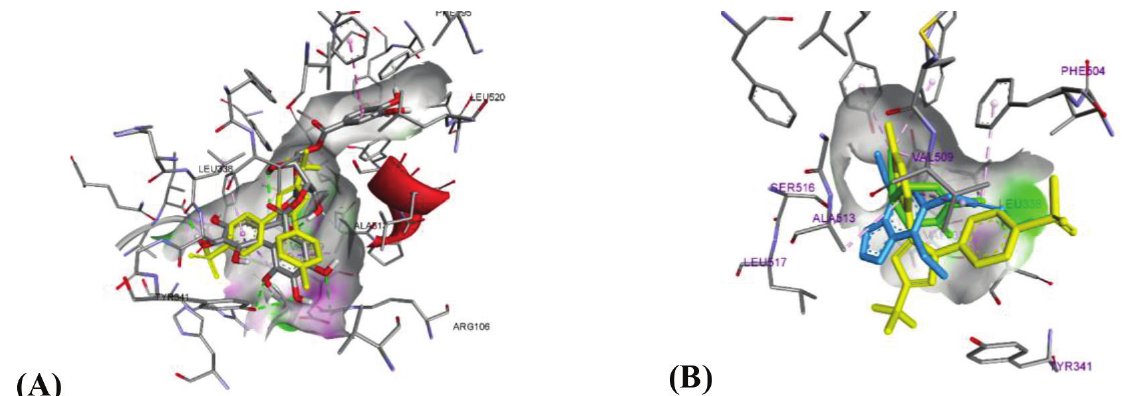
Figure 8. 3D visualization of ( A ) conformation of the native celecoxib ligand (yellow molecule) with gallotannin (grey molecule) (B) celecoxib compatible conformation with apiol (blue molecule) and carvone (green) in COX-2 active site.